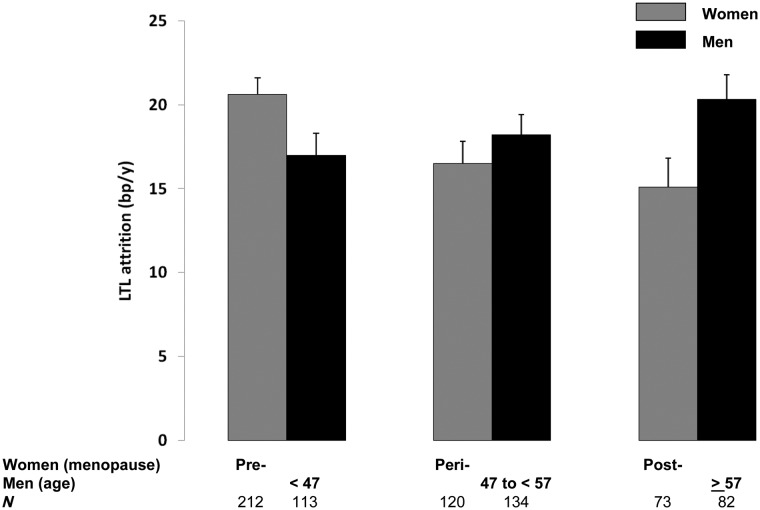
Comparisons of leukocyte telomere length attrition between women and men. Comparisons between women and men are based on the menopausal status of the women and the age of the men at the follow-up examination, which falls in the range of the age of the women categorized for their specific status; y, years. Data are presented as mean ± SE. For details, see text and Tables 2 and 3.